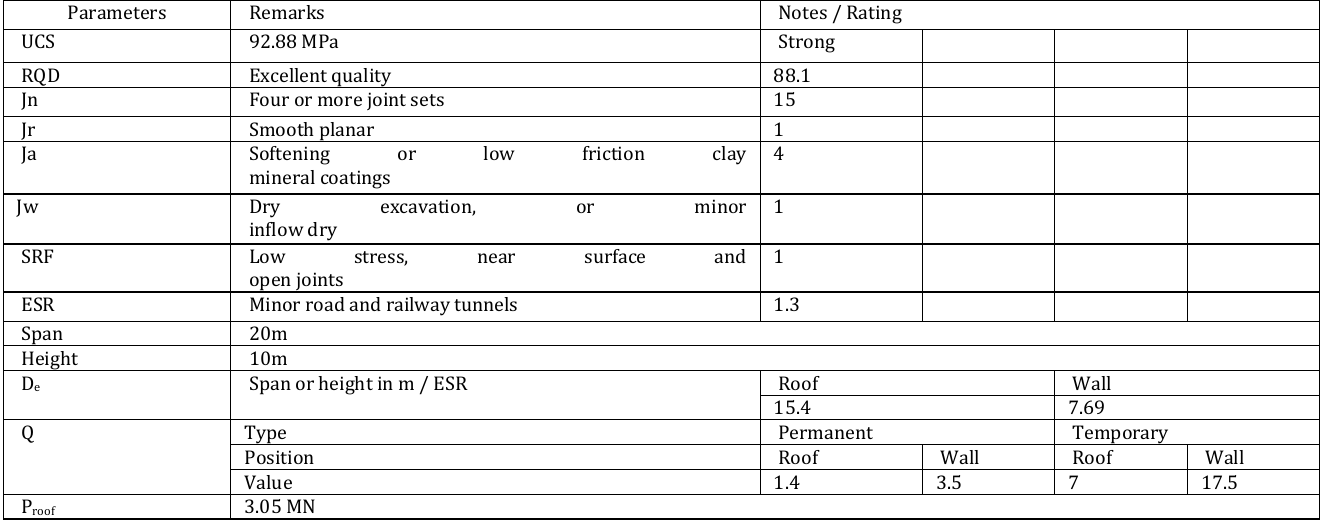
Table 1: Summary of the Q- system’s parameters and ratings, Q -value and related design parameters.